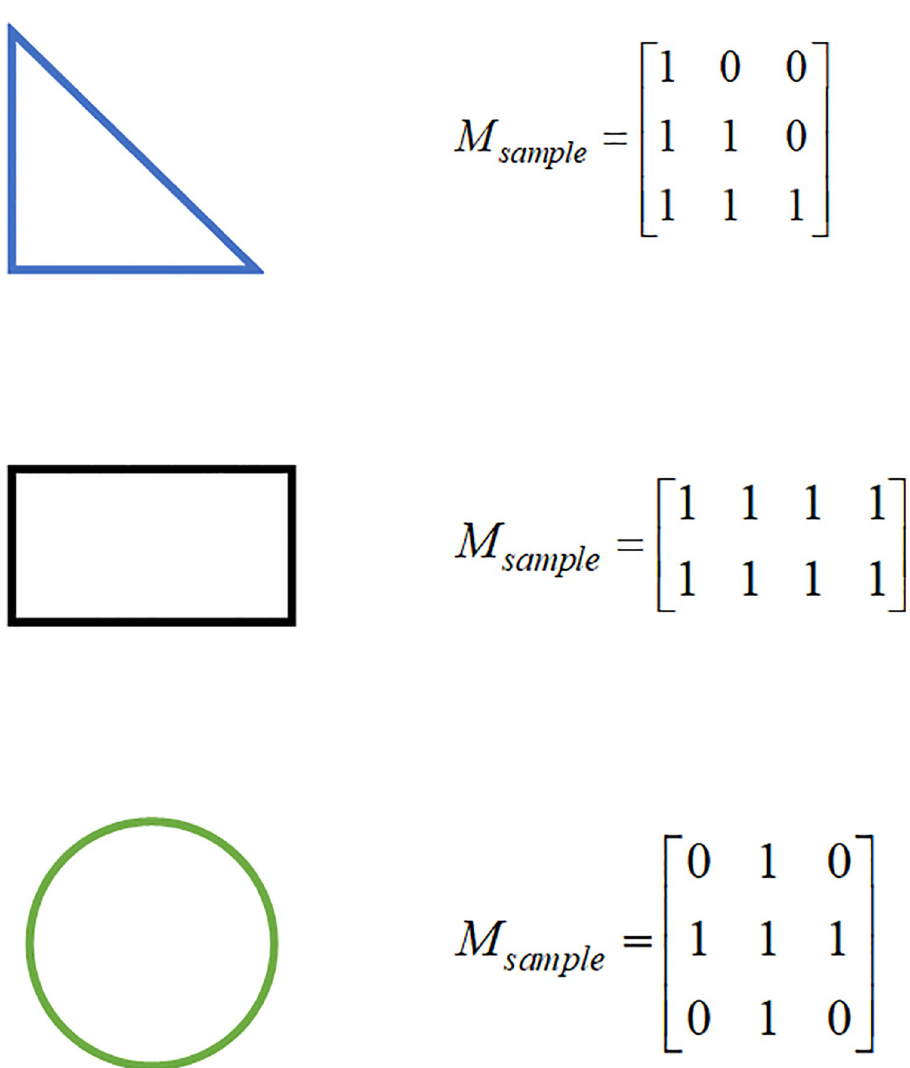
Fig 4. The sample matrix. Parts are represented as a sample matrix according to the part size information. The sample matrix size is the same as the smallest rectangle that can accommodate the part